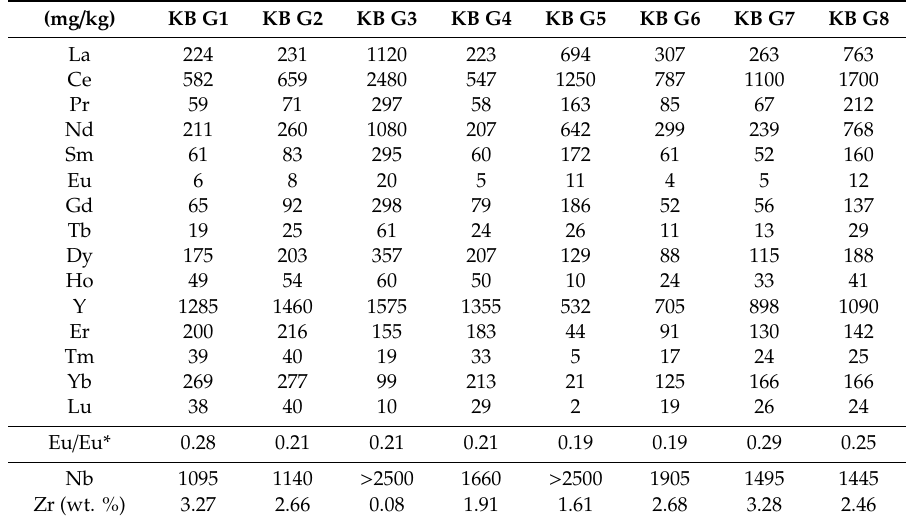
Table 3. Rare earth elements (REEs) + Zr and Nb composition of KB G. Zirconium data from handheld X-ray fluorescence (XRF) measurement. Europium anomaly Eu / Eu* calculated based on the geometric mean of normalized Sm and Gd values.